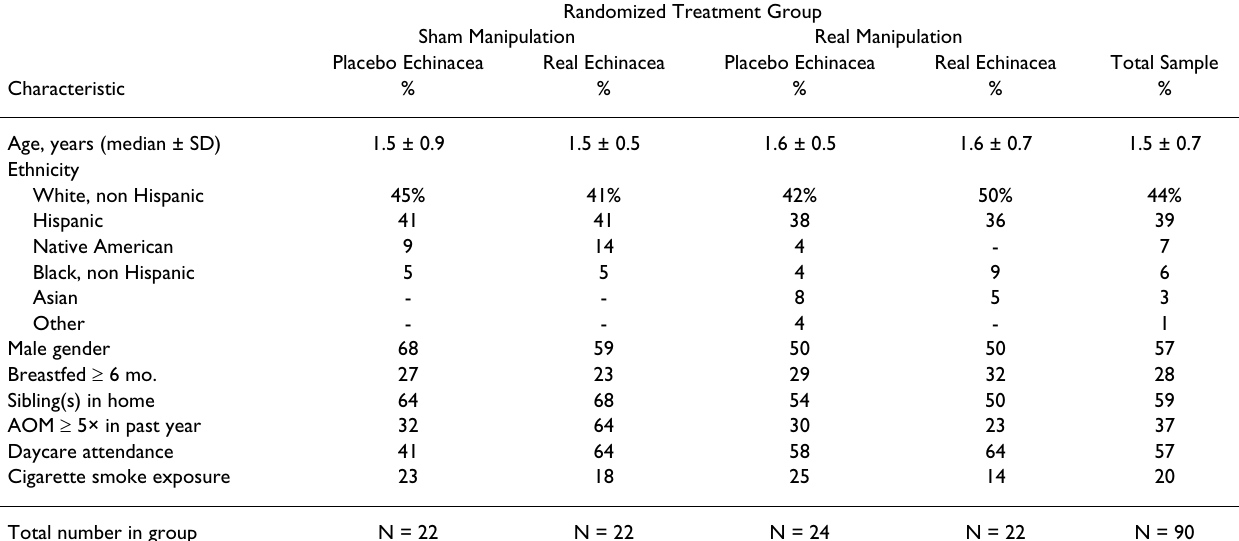
Table 1: Subject characteristics according to assigned treatment